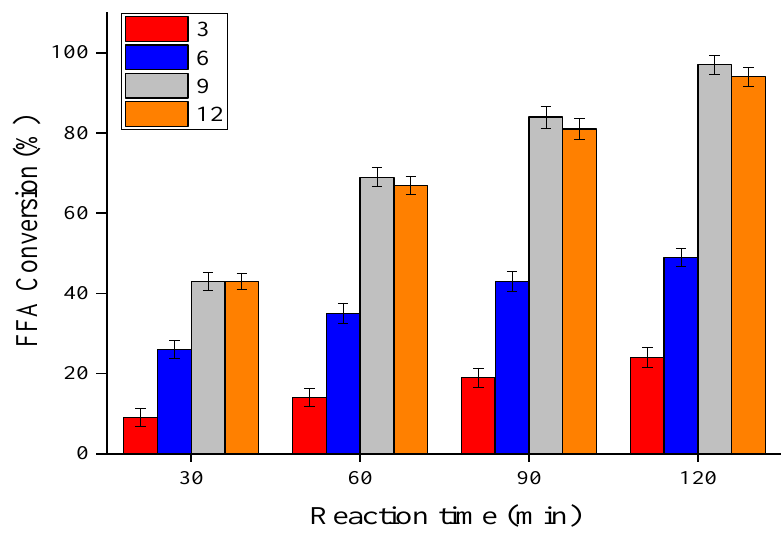
Figure 5. Effect of methanol to palm fatty acid distillate (PFAD) ratio on free fatty acids (FFA) conversion.